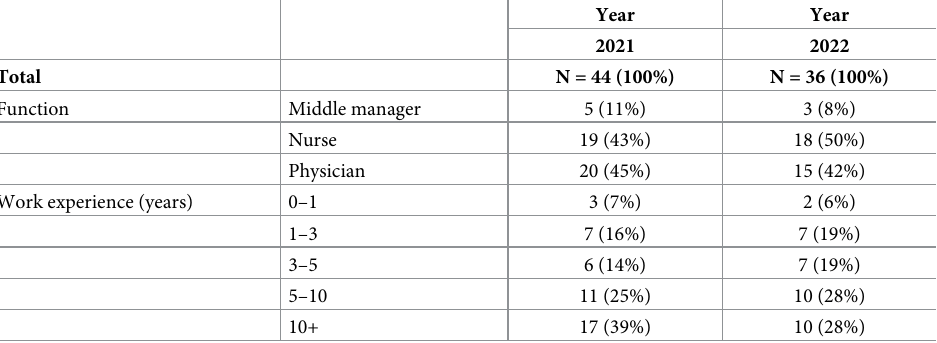
Table 1. Characteristics of study